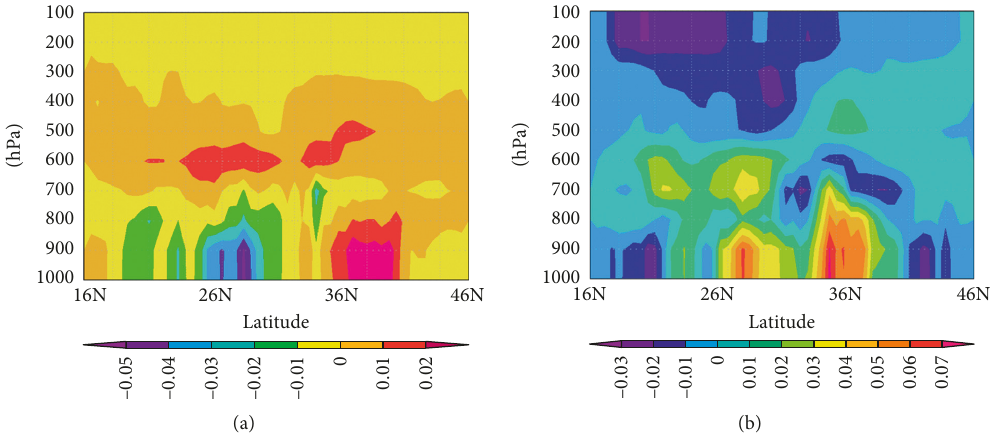
Figure 10: Zonal average temperature changes (K) due to BC aerosols. (a) Summer. (b) Winter.